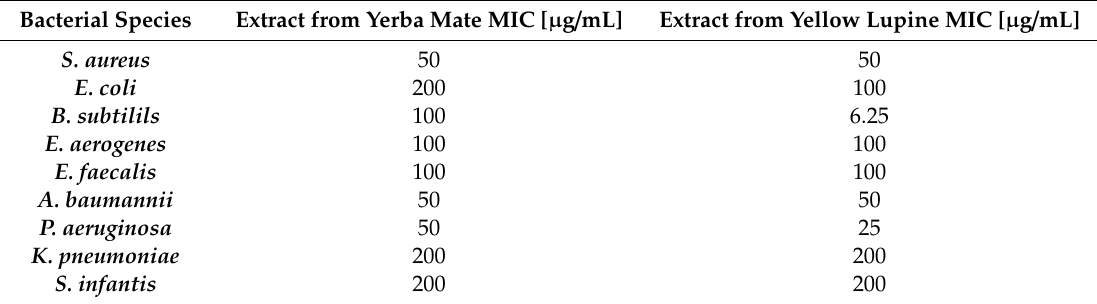
Table 3. Minimal inhibitory concentration (MIC) for EA-SFE extract from yerba mate and yellow lupine. Bacterial Species Extract from Yerba Mate MIC [ µ g / mL] Extract from Yellow Lupine MIC [ µ g / mL] S. aureus